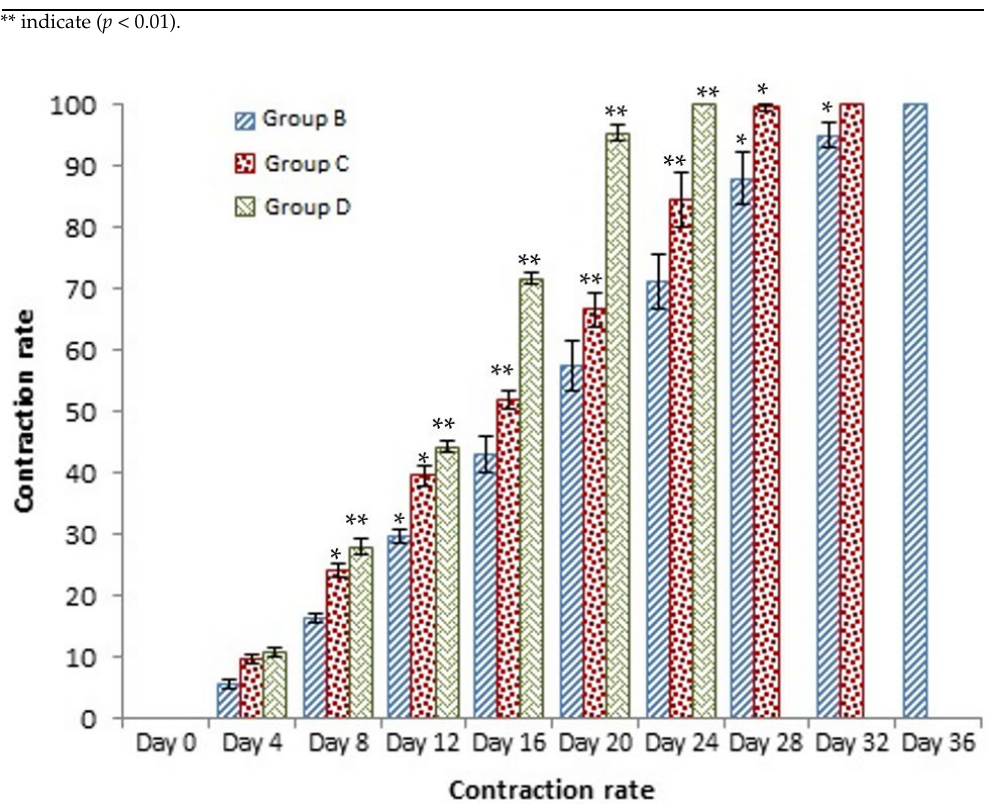
Sum of Squares Mean Squares Prob.